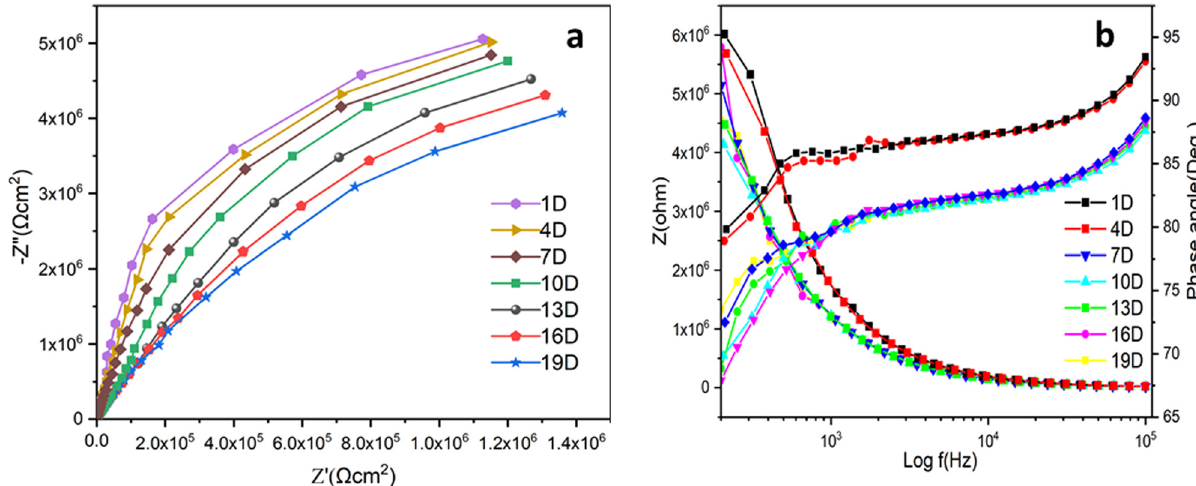
Figure 9: EIS ( a ) and Bodetheta ( b ) spectra of ROHA/SNP nanocomposite